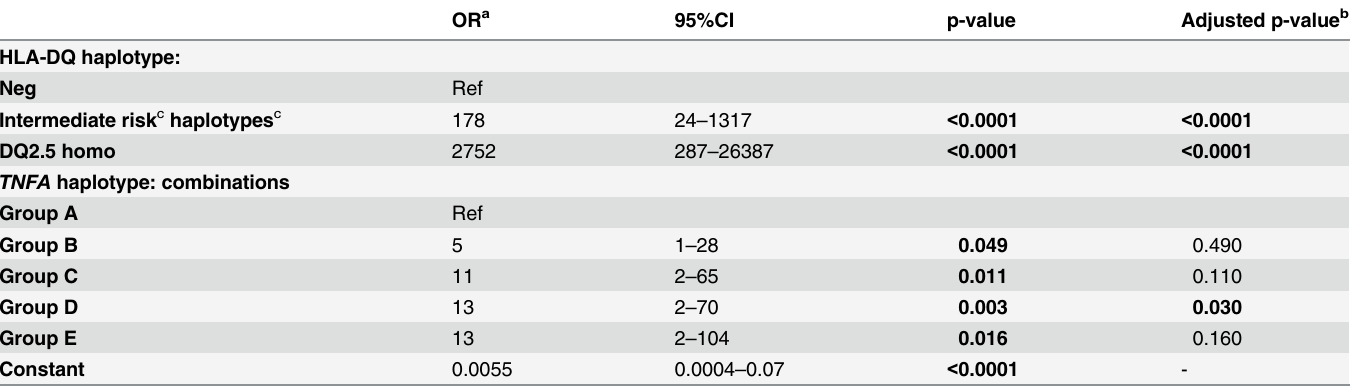
Table 4. Binary logistic regression analysis.